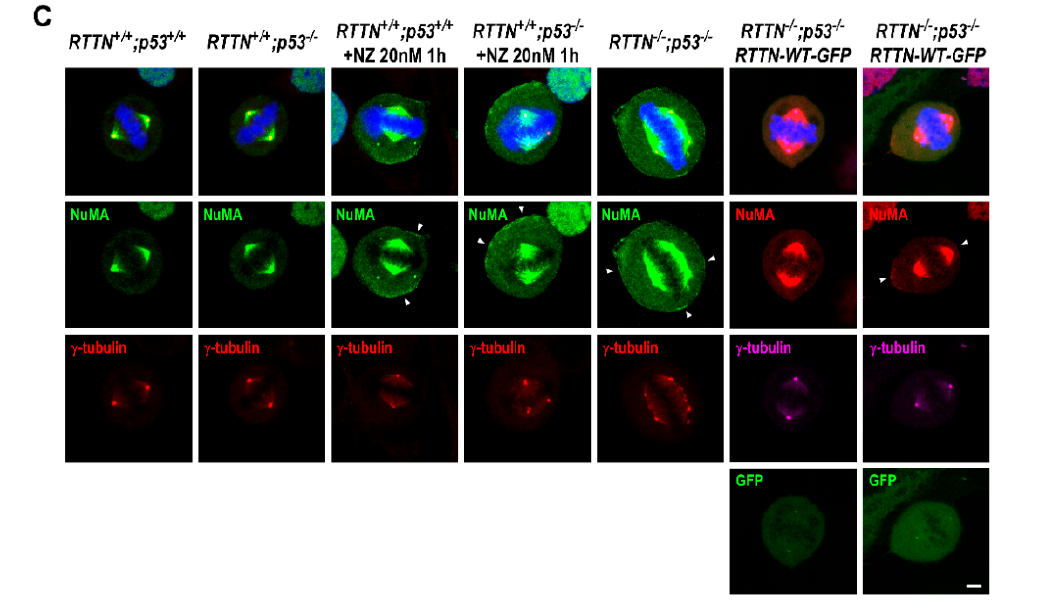
Figure 4. RTTN regulates cortical NuMA release through astral microtubules. RPE1-based RTTN +/+ ; p53 +/+ , RTTN +/+ ; p53 − / − , or RTTN − / − ; p53 − / − cells were treated as described in Figure 3F. ( A ) The effects on astral microtubules after RTTN knockout. To easily visualize the astral microtubules, the cells were pre-extracted with PHEM, fixed in methanol, and immuno-stained with the indicated antibodies. Arrows in ( A ) indicate the astral microtubules. ( A , middle panel) Quantification data of the length of each astral microtubule ( n = 1989 for RTTN +/+ ; p53 +/+ group; n = 1988 for RTTN +/+ ; p53 − / − group; n = 1032 for RTTN − / − ; p53 − / − group). ( A , right panel) Histograms illustrating the number of astral microtubules per spindle pole ( n = 90 for each group). Data are represented as the mean ± SEM from three independent experiments. ( B , C ) The effects of nocodazole (NZ) treatment in astral microtubule assembly ( B ) and cortical NuMA distribution ( C ). For nocodazole (NZ) treatment, cells were treated with or without 20 nM of NZ for 1 h in the presence of 5 µ M MG132. After treatment, cells were immuno-stained with indicated antibodies, followed by confocal fluorescence microscopy. DNA was counterstained with DAPI. Arrowheads in ( C ) indicate the cortical NuMA. In the rescue experiment ( C ), the spindle pole integrity and the abnormal distribution and the retention of cortical NuMA could be partially rescued by exogenously expressing RTTN -WT-GFP in the RTTN − / − ; p53 − / − cells. ( D ) Histograms illustrating the percentages of metaphase cells with cortical NuMA (both lateral and mis-localized patterns). Data are represented as the mean ± SEM from three independent experiments. Data are analyzed by one-way ANOVA with Tukey’s multiple comparison test. *** p < 0.0001. Scale bars: 5 µ